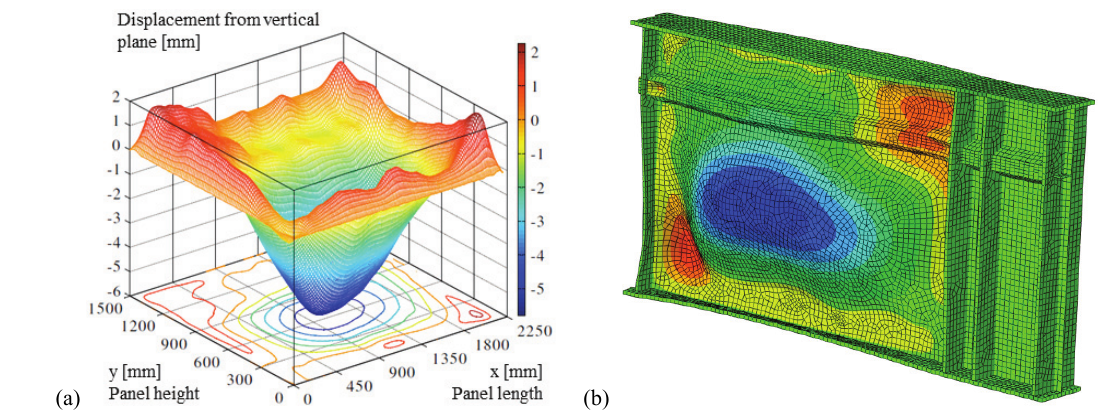
Fig. 6. Geometric imperfections (deformations) of panel